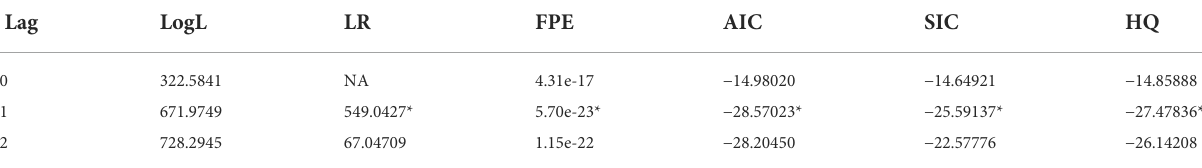
TABLE 5 Lag selection criteria.